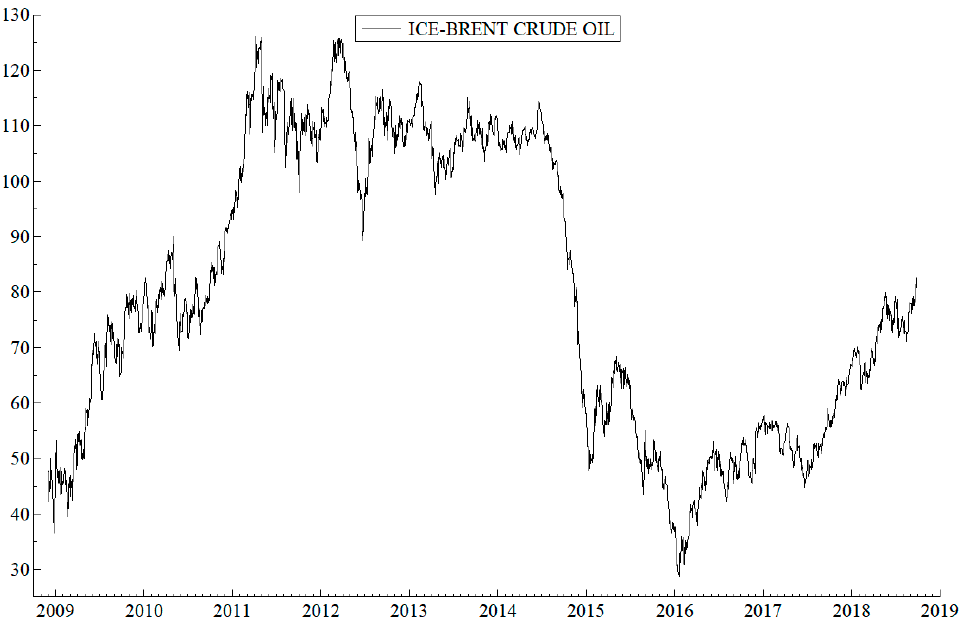
Figure 7. Daily prices in ICE Brent oil monthly futures in USD/barrel, 2 December 2008 to 28 September 2018.